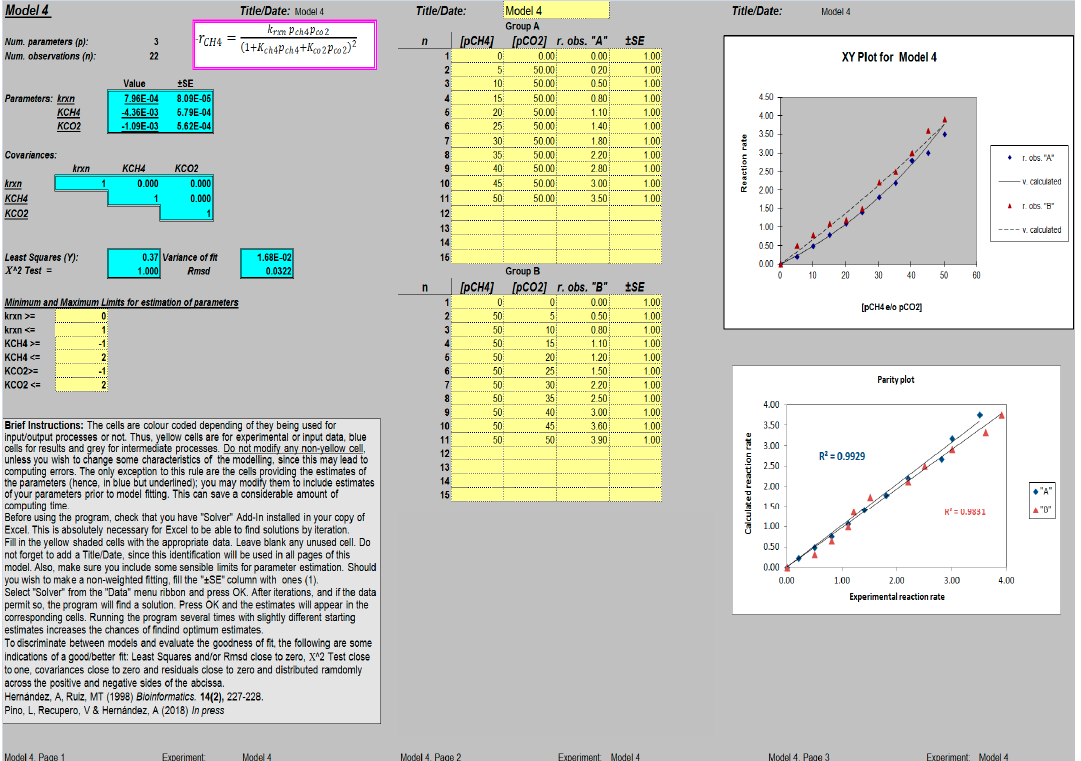
Figure 1. Screen capture of a worksheet template for the determination of kinetic parameters ( k , K CH4 and K CO2 ; Model 4 [19]); after reaching convergence, the variance of the fit and Rmsd values, together with additional graphs showing the original data vs. the independent variables ( p CH4 and/or p CO2 ) and a parity plot (experimental vs. calculated rate), are displayed.